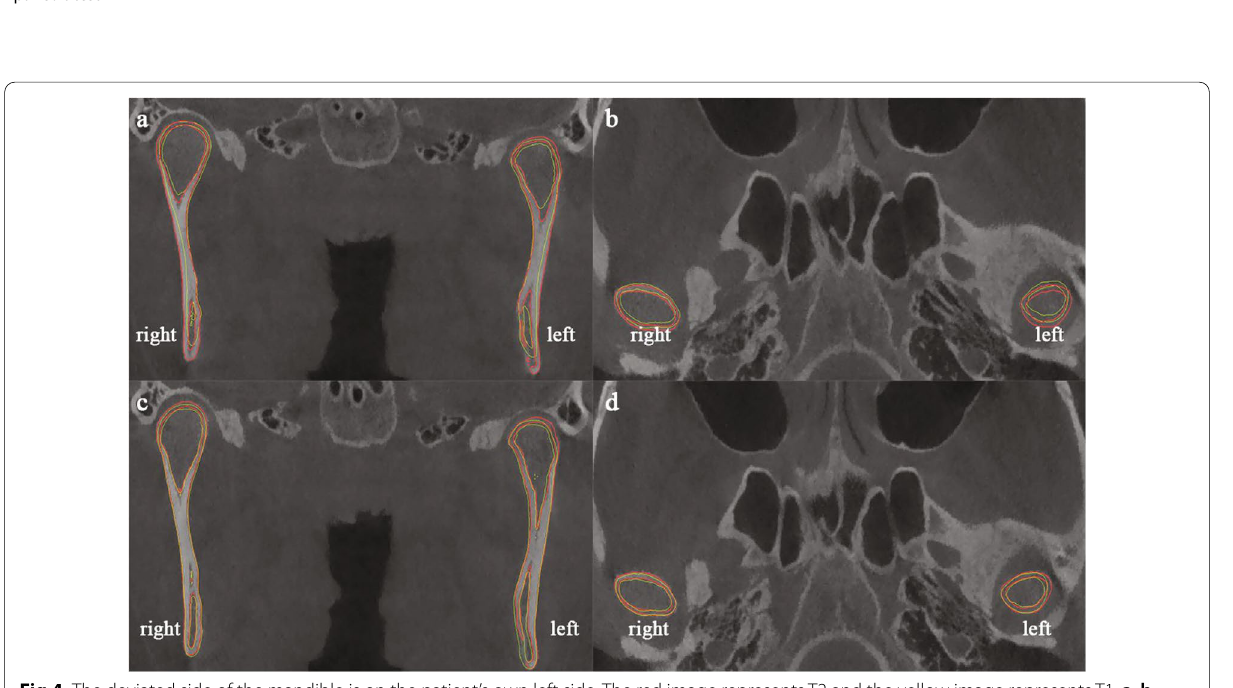
DS, deviated side; NDS, non-deviated side; *indicates a statistical significance at P < 0.05. Abbreviations are summarized in Table 1 †